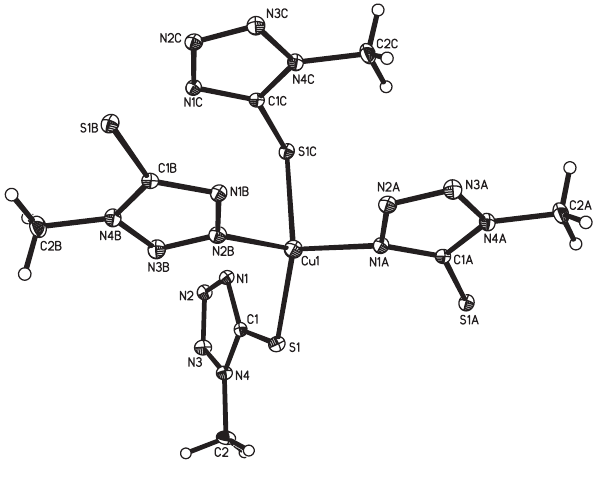
Table 1: Data collection and handling.